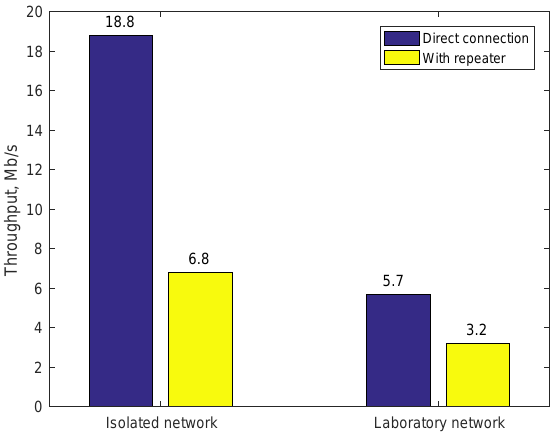
Figure 7. Throughput of isolated and laboratory networks in laboratory condition